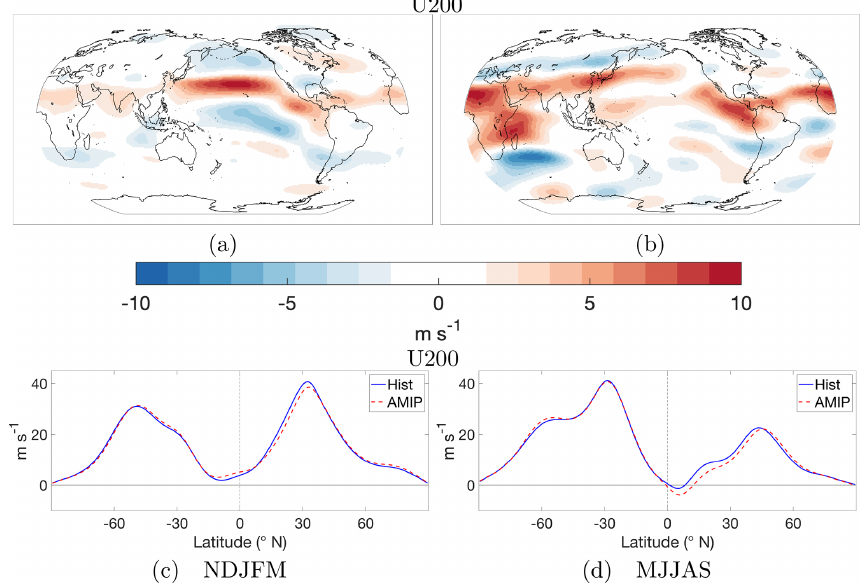
Figure 9. Seasonal differences between fully coupled E3SM and AMIP simulations – zonal wind at 200hPa (a, b) and zonal means over the Pacific and Atlantic basins (100–360 ◦ E) of zonal wind at 200hPa (c, d)